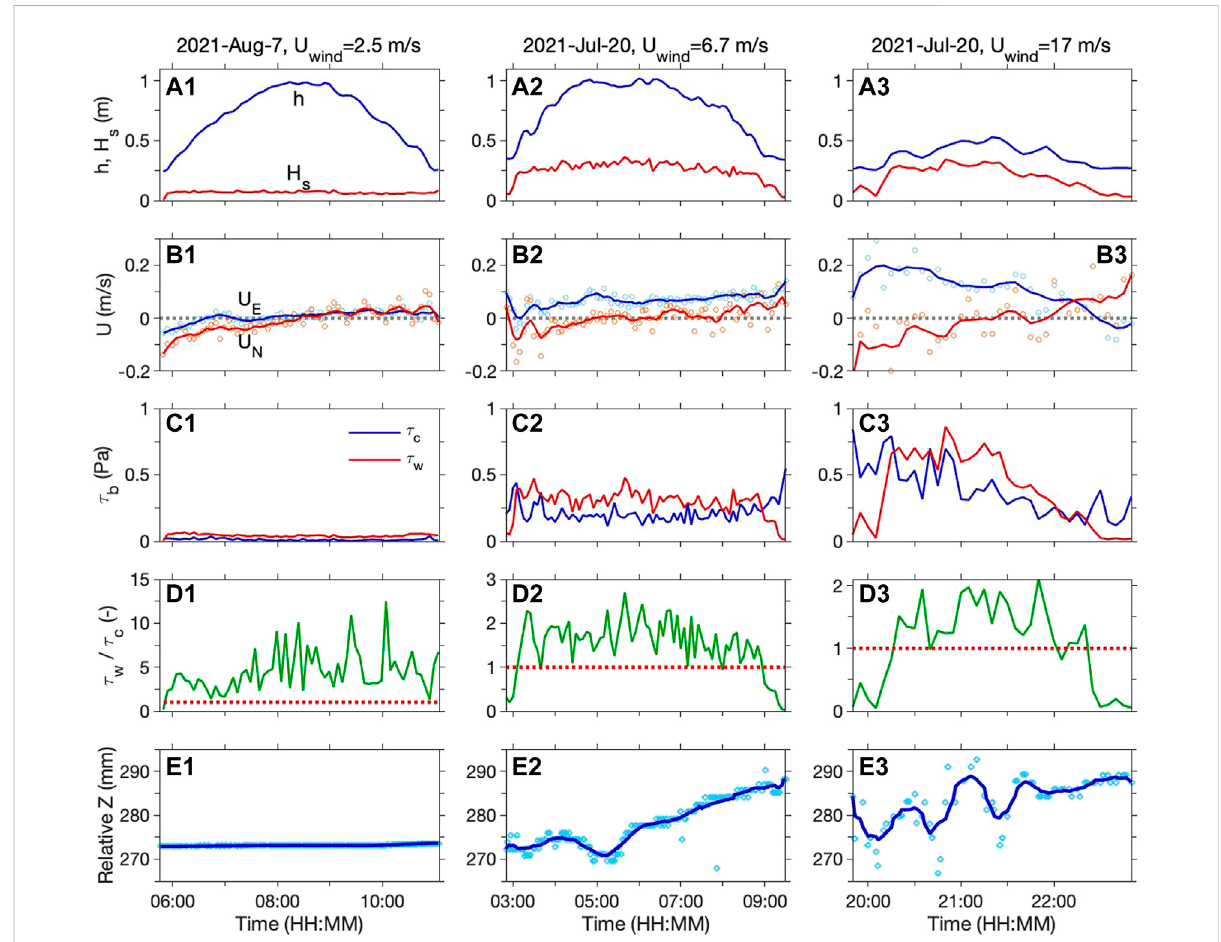
(Figure 3A). The maximum wind speeds and predominant directions were 8.0 m/s and north-east-north in Period 1, and 17.0 m/s and north and east in Period 2, respectively (Table